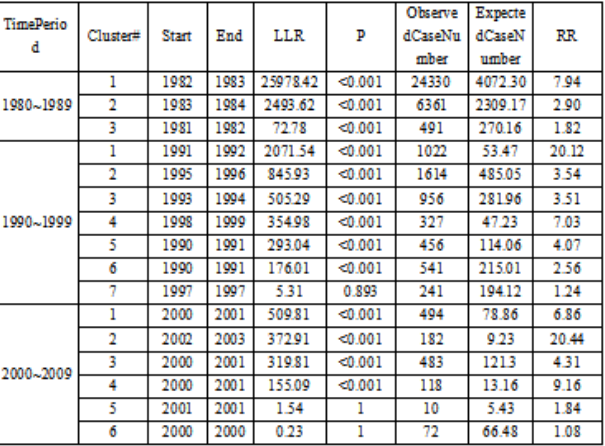
Table 1. Detection of HFRS Clusters in Hubei Province,